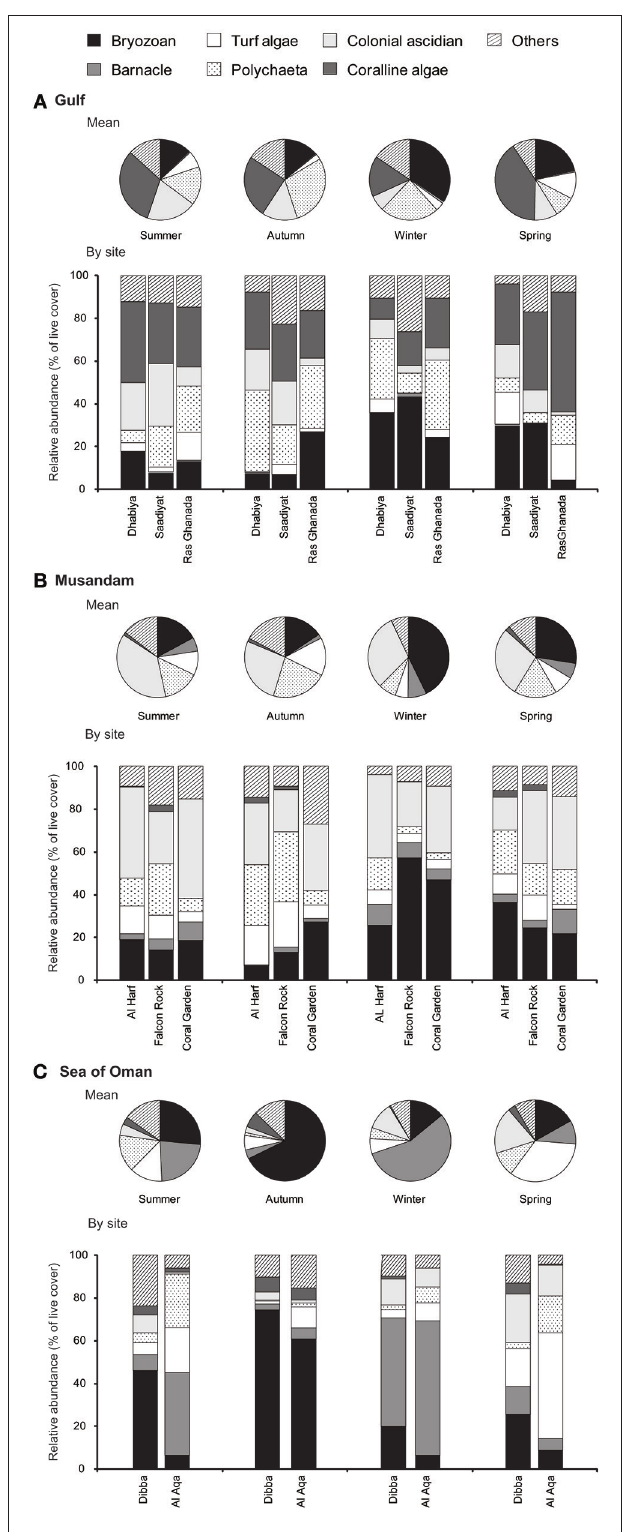
FIGURE 3 | Seasonal changes in benthic community structure: (A) across the Gulf and within each Gulf site, (B) across Musandam and within each Musandam site, (C) , across the Sea of Oman and within each Sea of Oman site. Values are shown as relative abundance (percentage of benthic